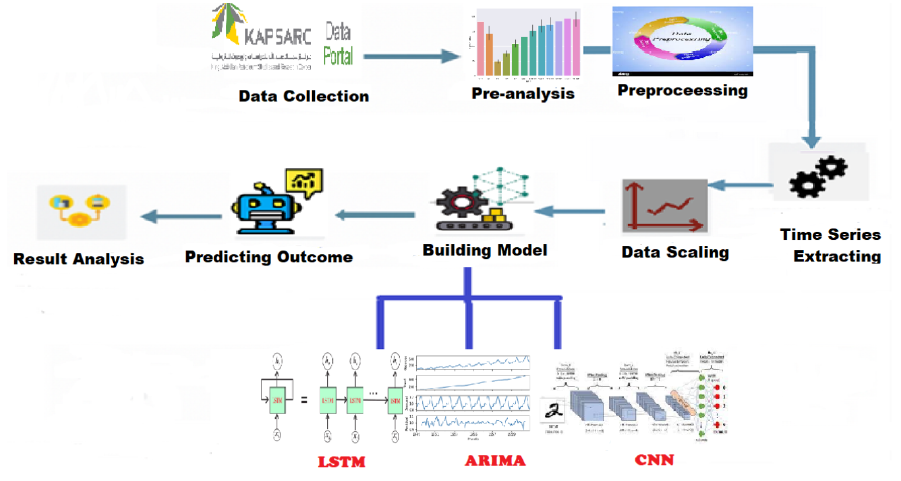
Figure 1. Methodology